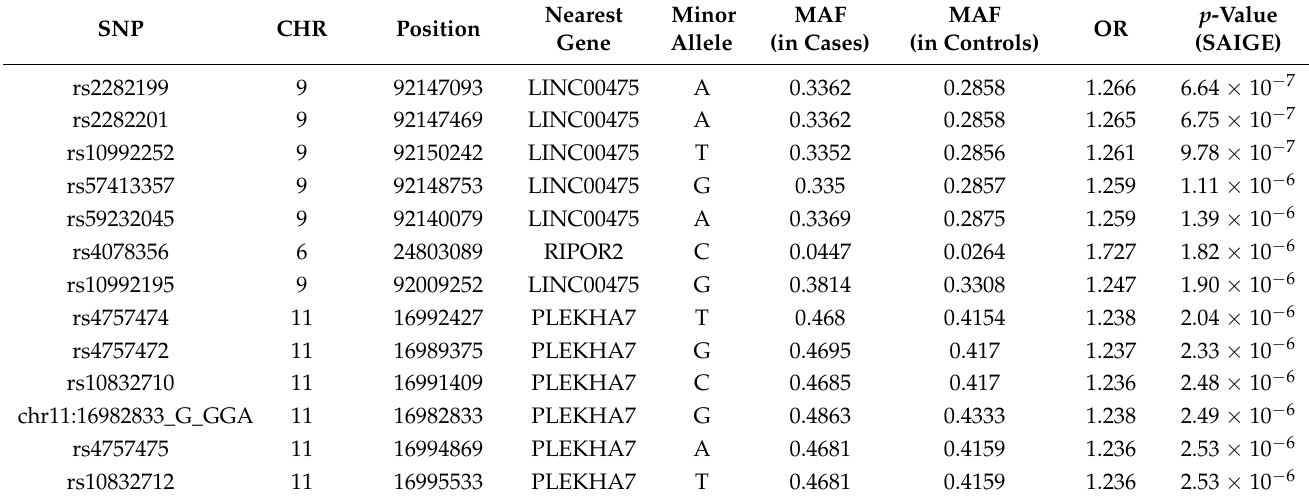
Figure 1. Manhattan plot showing the individual p -values against genomic position for individuals ( n = 1013 cases, n = 36,562 controls) from Taiwan Biobank 2.0 (TWB2.0). Table 2. Selected glaucoma-associated single nucleotide polymorphisms (SNPs) identified in Taiwan Biobank 2.0 (TWB2.0). For a complete list of all 138 genome-wide significant glaucoma-associated SNPs ( p < 1 × 10 − 5 after SAIGE adjustments), please refer to Table